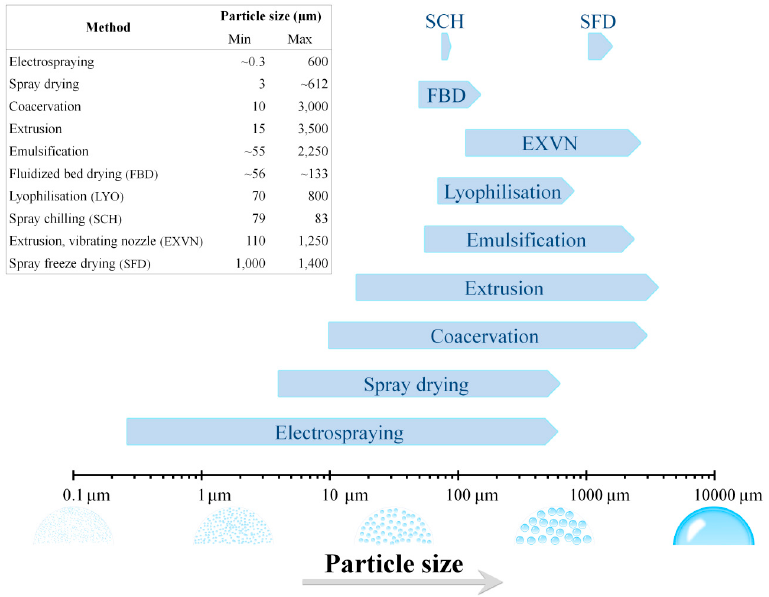
Figure 1. Output particle size ranges of the different methods employed for the microencapsulation of probiotic microorganisms.